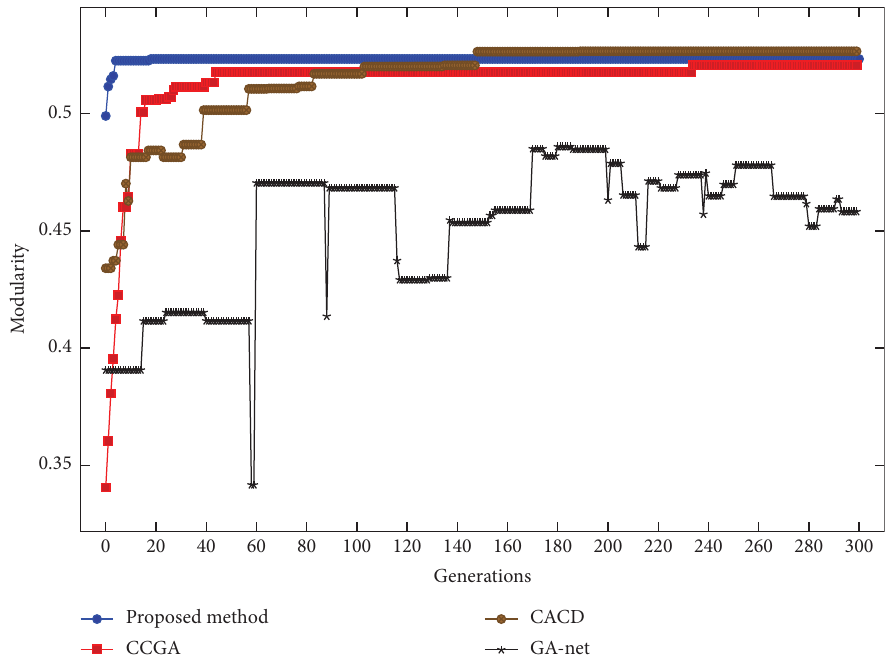
Figure 10: Comparison of the results of the proposed method with other GAs on the Polbooks dataset. We ran all of the methods by a population size of 100 for 300